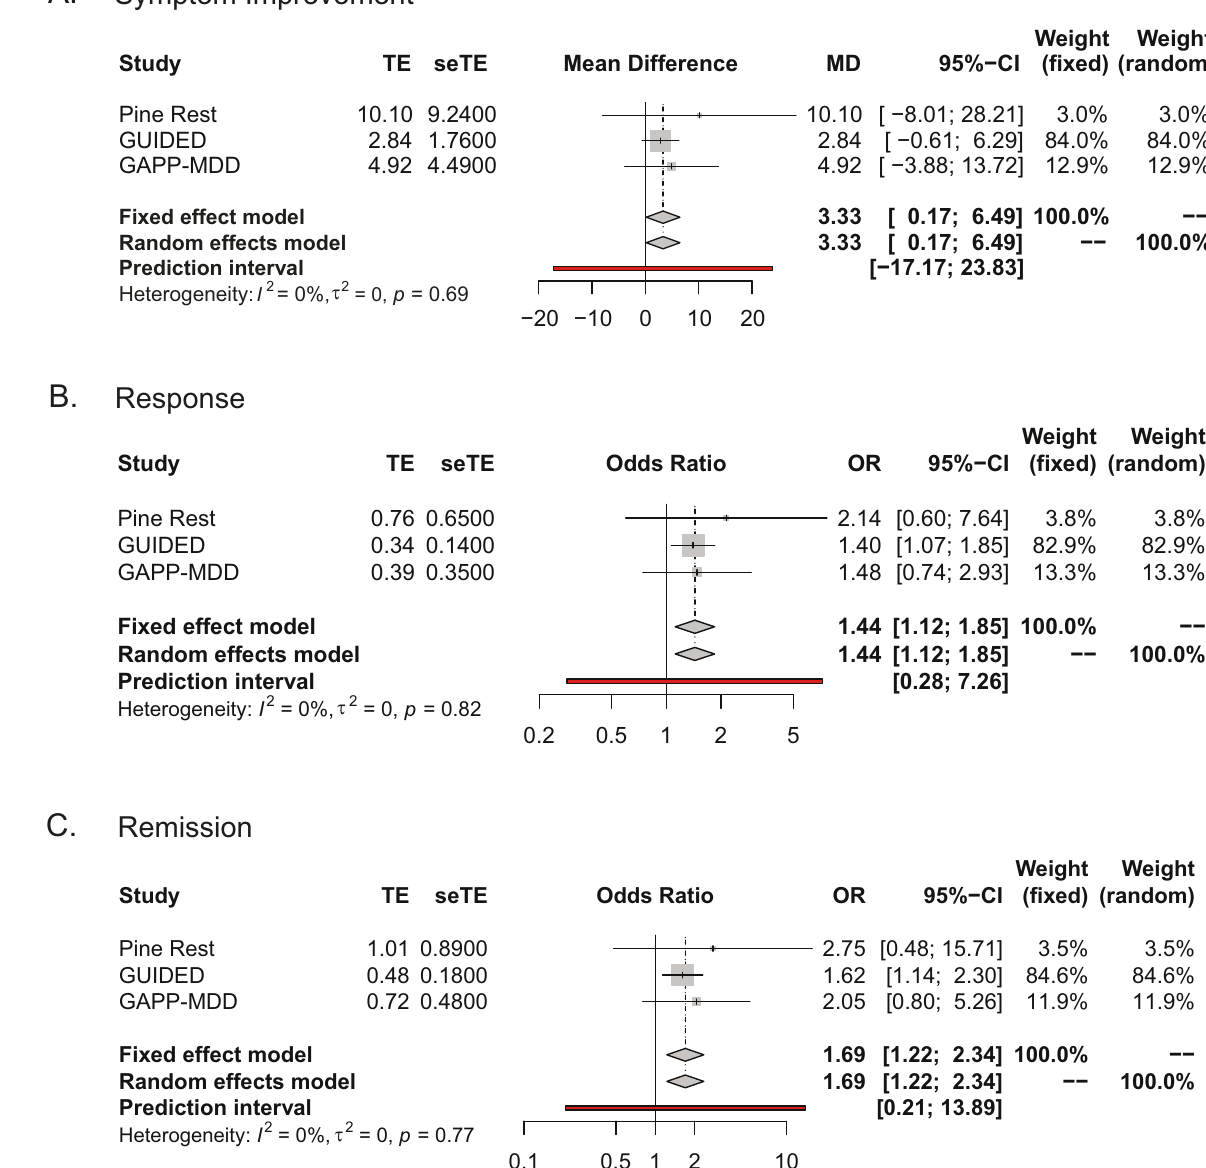
Fig. 3 Meta-analysis of randomized-controlled trials evaluating combinatorial pharmacogenomic testing. A Meta-analysis of symptom improvement. B Meta-analysis of response. C Meta-analysis of